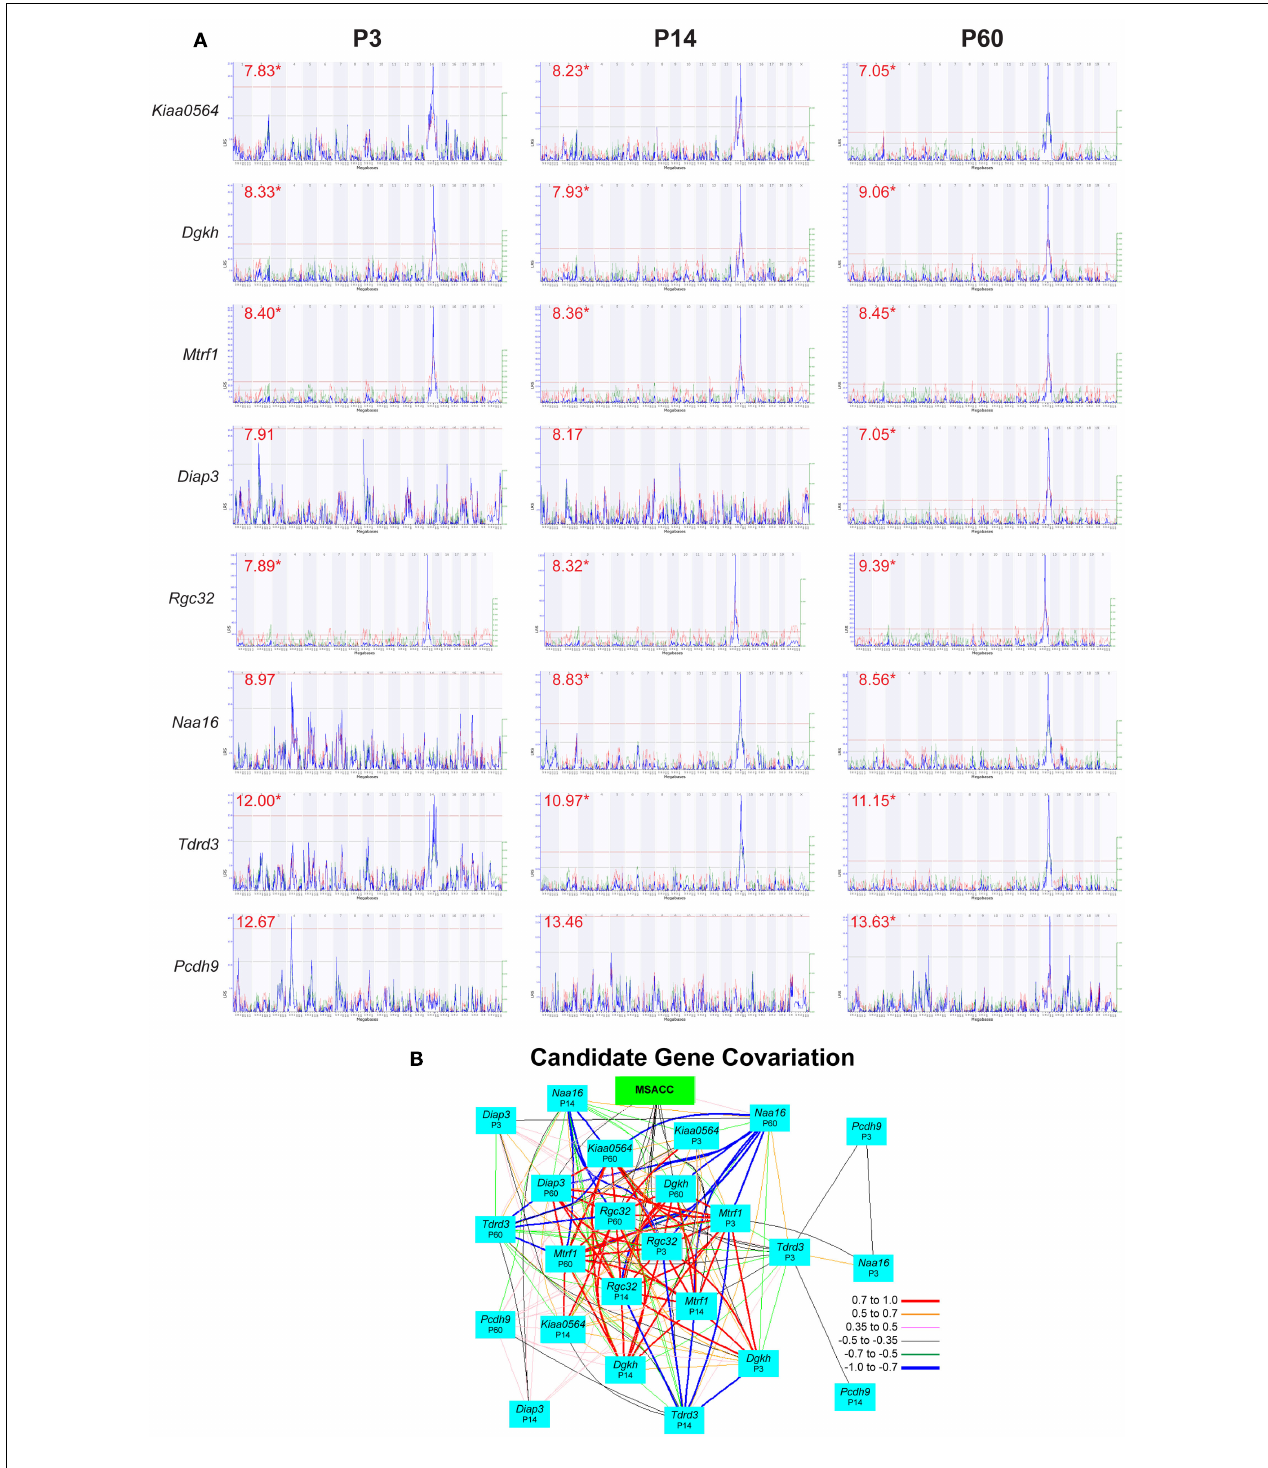
Numbers in red indicate mean expression level of the gene, and asterisks indicate cis-eQTLs. (B) Network graph illustrating correlations among MSACC and positional candidate gene expression from the three